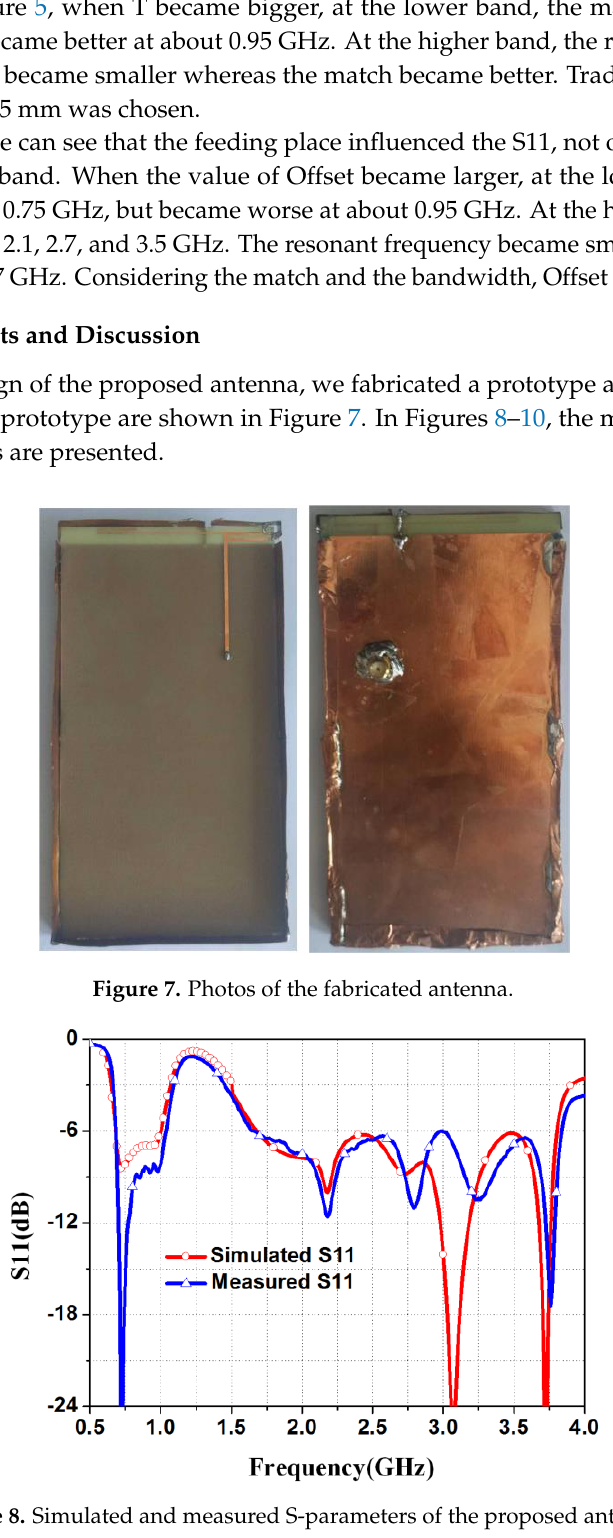
Figure 8. Simulated and measured S-parameters of the proposed antenna.